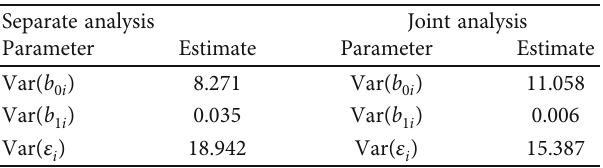
Table 5: Covariance parameter estimates under separate and joint